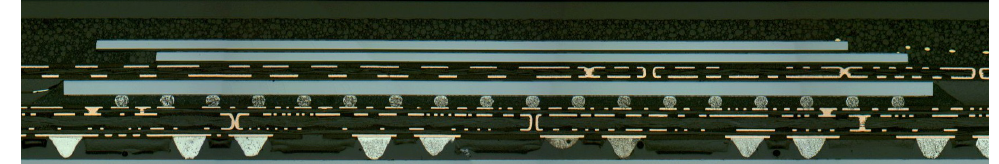
Figure 2: Cross-section of the A4 processor + RAM Package on Package (PoP) (taken from iFixit A4 teardown